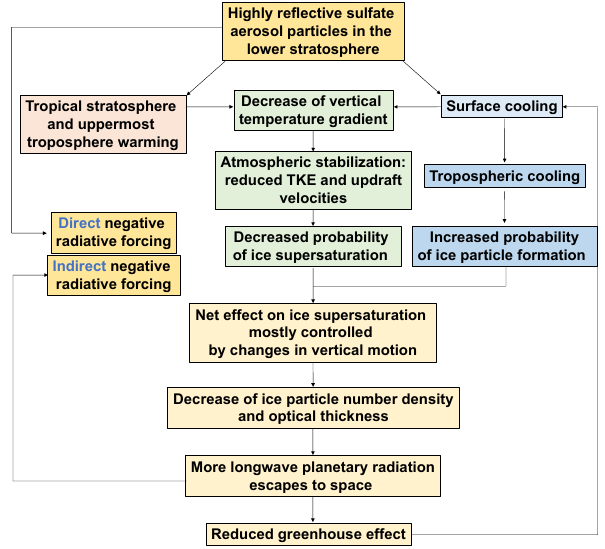
Figure 15. Schematic summary of the sulfate geoengineering im- pact on the dynamical processes driving changes of upper tropo- spheric ice particle formation through homogeneous